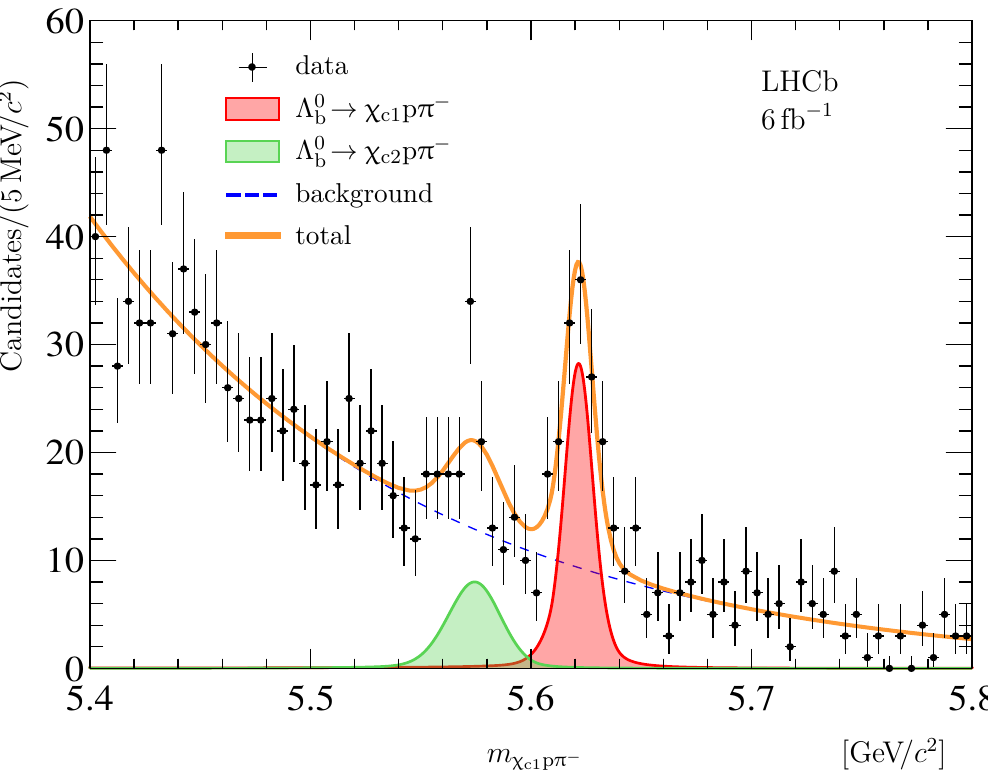
→ (cid:31) cJ p (cid:25) − candidates. A fit, described in the text, b